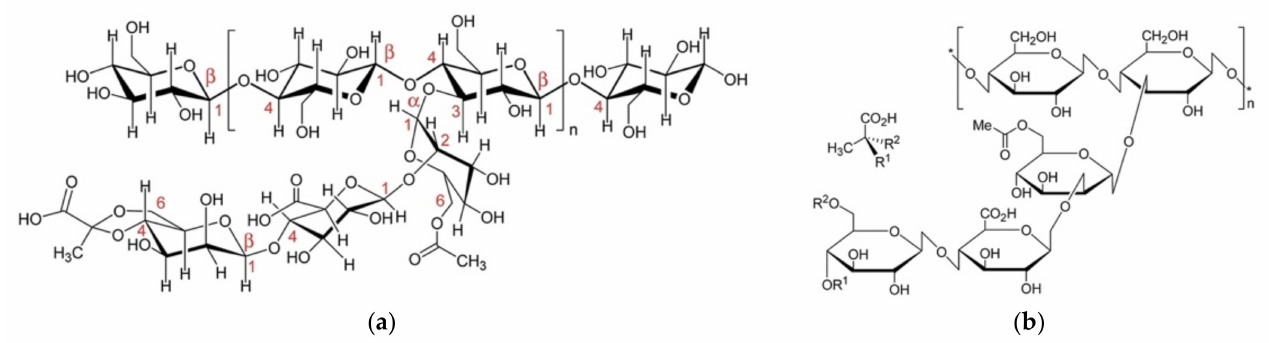
Figure 9. Chemical structure of xanthan gum, ( a ) chair, and ( b ) Haworth projection